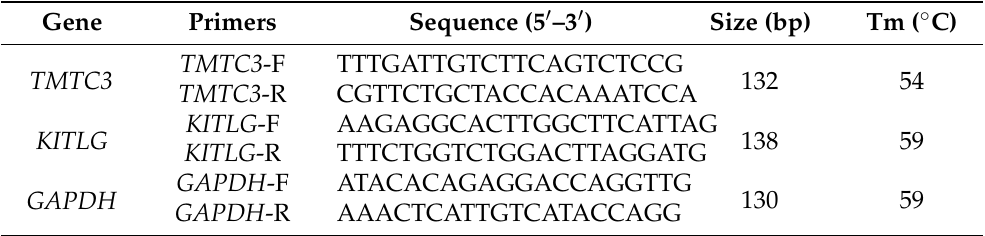
Table 1. Primers used in